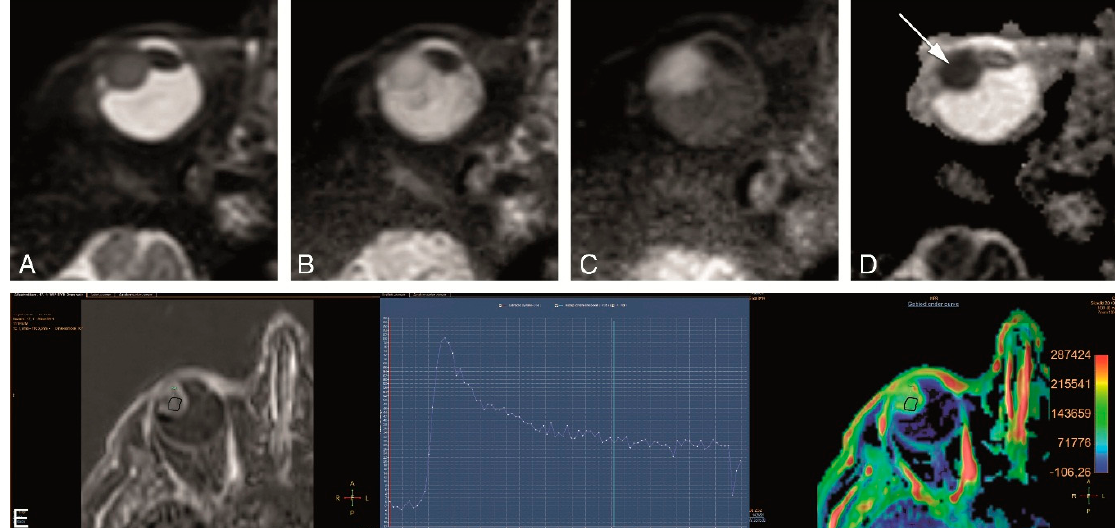
Figure 3. ( A – E ). Study protocol: Functional axial MRI sequences in the same patient as in Figure 2. ( A – D ) TSE DWI, with b values of 0 s/mm 2 ( A ), 400 s/mm 2 ( B ), 800 s/mm 2 ( C ) and Apparent Diffusion Coefficient (ADC) ( D ). Restricted diffusion in the uveal melanoma (arrow). ( E ) Dynamic Contrast-Enhanced (DCE) with a good quality, no movement artefacts, showing a wash-out TIC pattern.